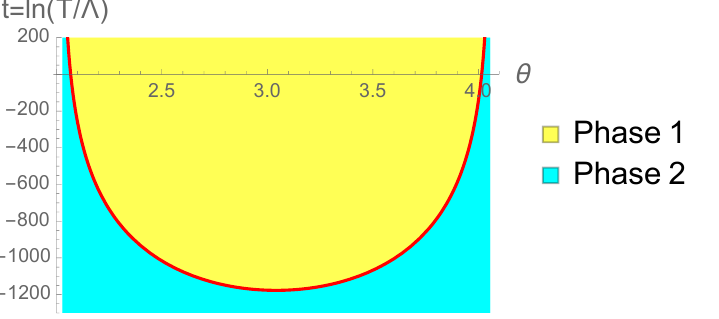
Figure 6. Phase diagram of the systems with r = 0 . 1 , λ = 0 . 001 , baryon symmetry in the first sector is unbroken while the baryon symmetry in the second sector is spontaneously broken. In Phase 2, the baryon symmetries in both the sectors are unbroken. The red line in this diagram is the line of critical points separating the two phases. It is the same as the curve given in figure